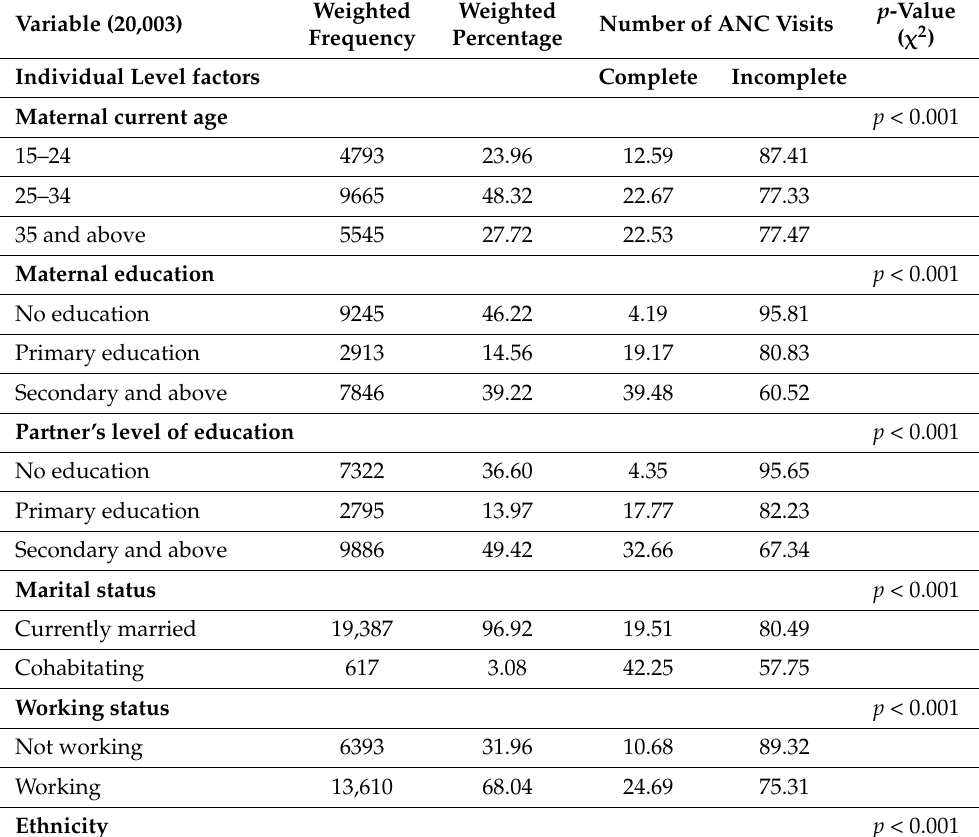
Table 1. Individual- and household-level characteristics of respondents by ANC visits in